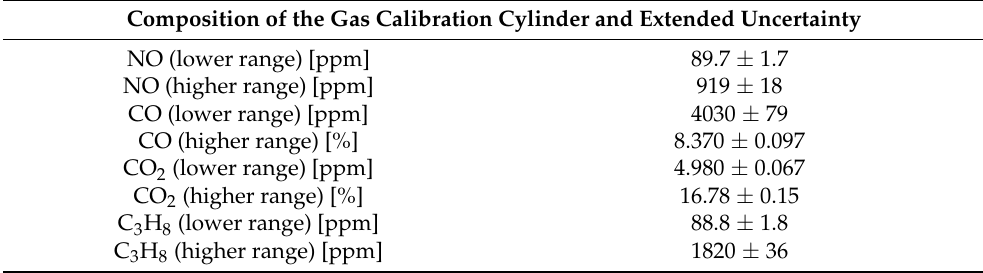
Table 2. Composition of the gas calibration cylinders and extended uncertainty (95% confidence interval).